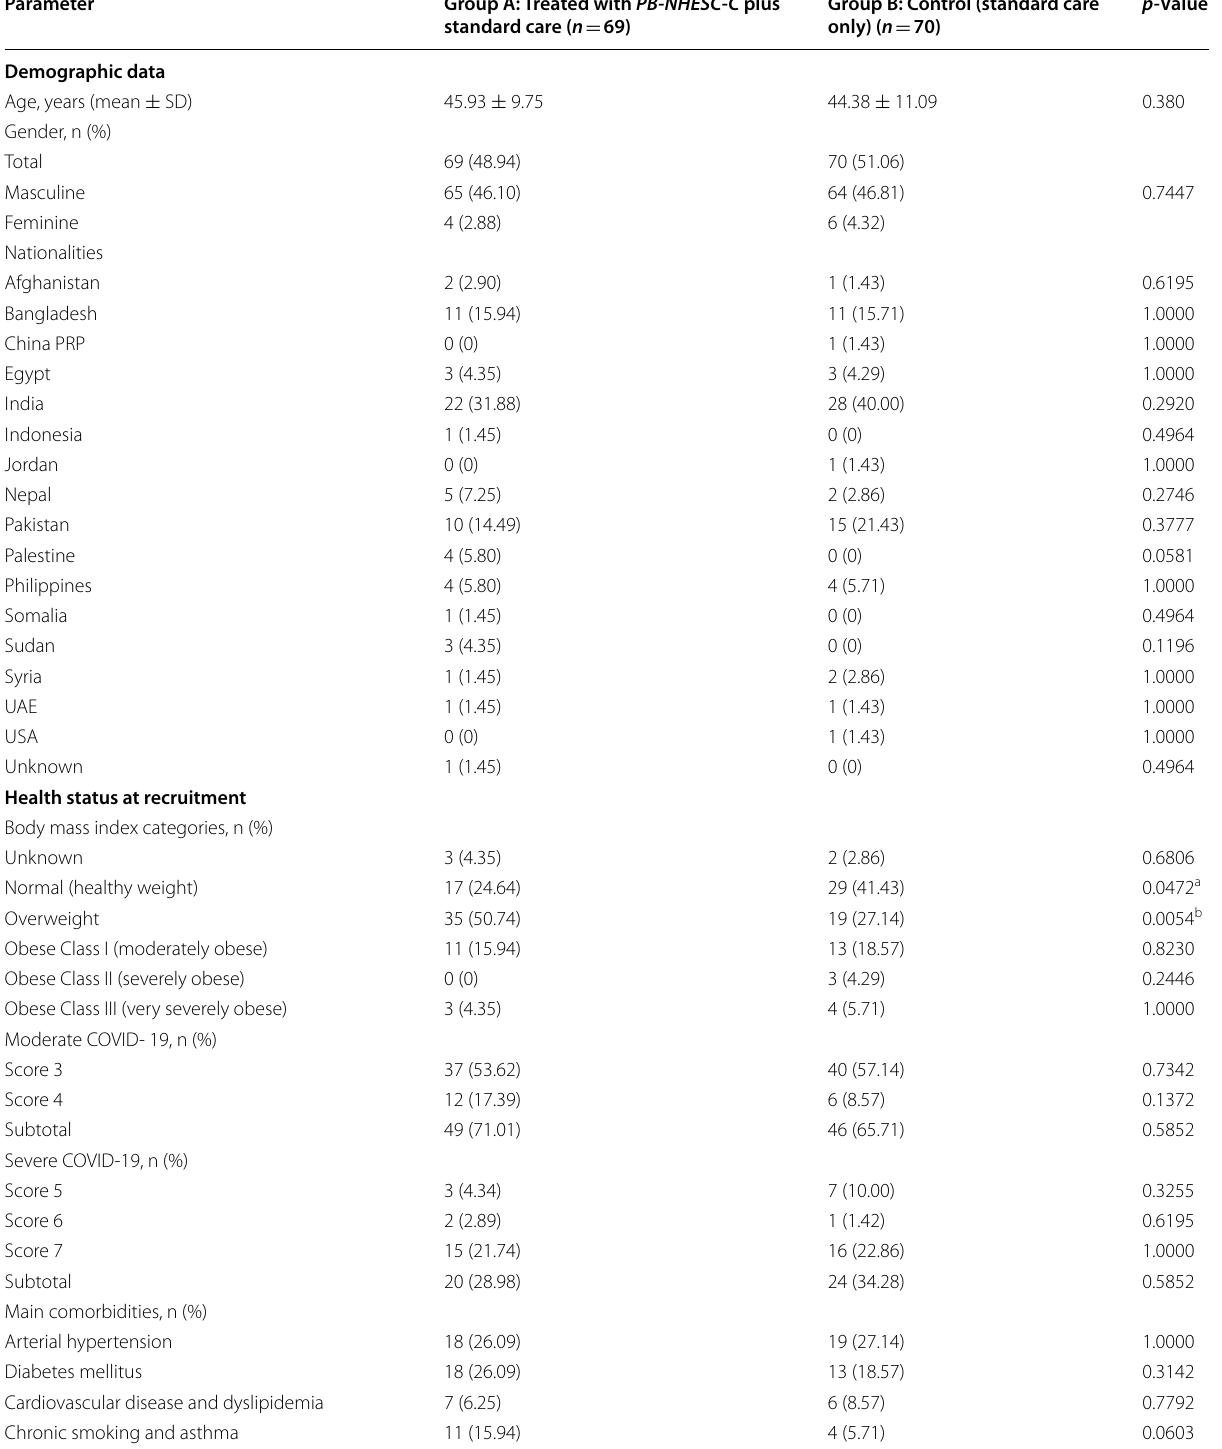
Table 1 Demographic data and clinical status of the enrolled patients on the recruitment